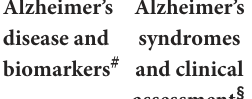
TABLE 1 Differential contribution of AD research lines to prevention, diagnosis, management and